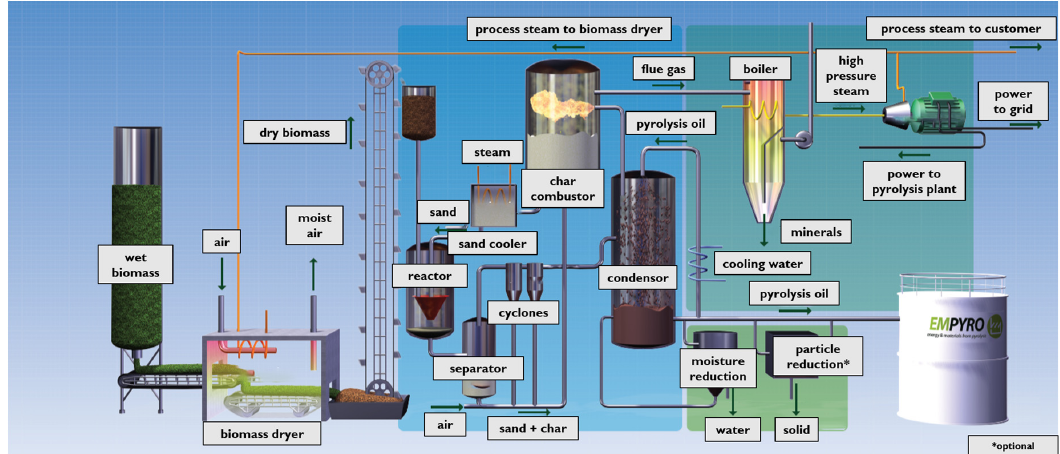
Figure 2. Pyrolysis plant. With permission from BTG Bioliquids BTG bioliquids BV